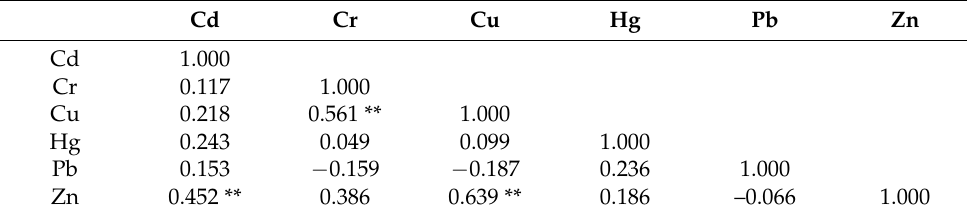
Table 9. Pearson correlation matrix of heavy metals in topsoil.